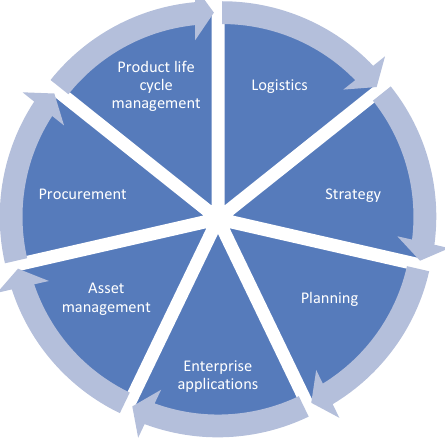
Fig. 1. Supply chain